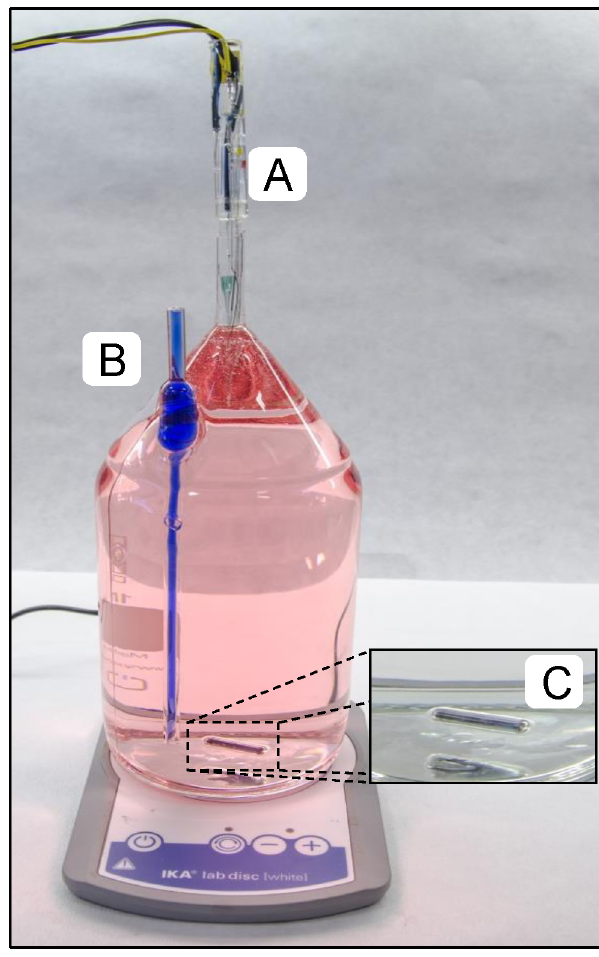
Figure 1. Incubation bottle. Glass bottle for incubations with a volume of 1160 mL (red ink was injected to increase the contrast). A) Opening (internal diameter 8.1 mm) for insertion of the STOX sensor; B) long open glass tube (internal diameter 2.5 mm) for pressure compensation (blue ink was injected inside the tube to increase the contrast); C) glass coated magnet (2.5 cm) for constant